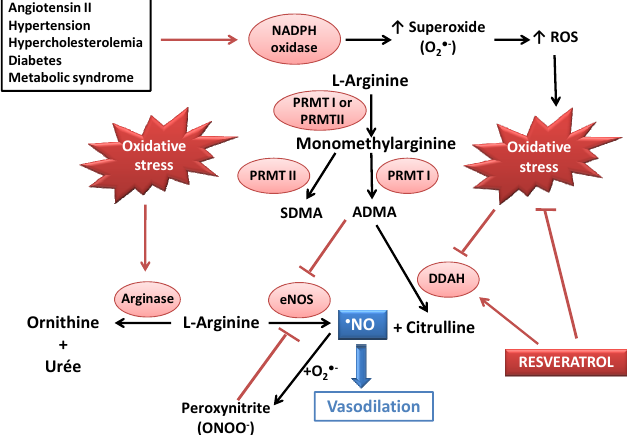
Figure 1. Deleterious effects of oxidative stress on ‚ NO bioavailability, and potential beneficial action of resveratrol (RES) as an antioxidant and as a modulator of the dimethylaminohydroase (DDAH)/asymmetric dimethylarginine (ADMA) pathway. CVDs could lead to increased ADMA concentrations (due to DDAH inhibition) and activation of NADPH oxidase, leading to oxidative stress. ADMA and peroxynitrite both induce eNOS decoupling, resulting in a decreased ‚ NO availability. RES could act as an antioxidant agent (radical scavenging and stimulation of antioxidant defenses) and as an activator of DDAH. ADMA: asymmetric dimethylarginine; DDAH: dimethylarginine dimethylaminohydrolase; eNOS: endothelial NO synthase; PRMT: protein methyltransferase; ROS: Reactive oxygen species; SDMA: symmetric